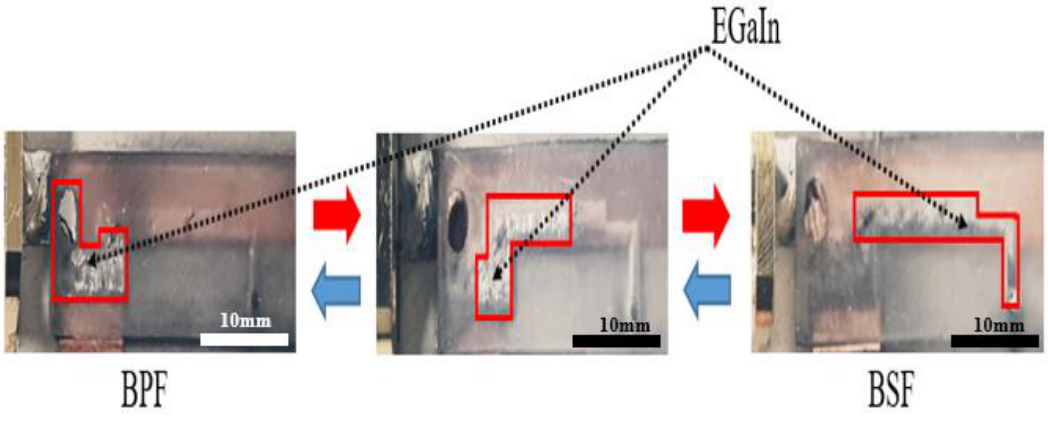
Figure 6. Snapshot pictures for the liquid metal moving direction.